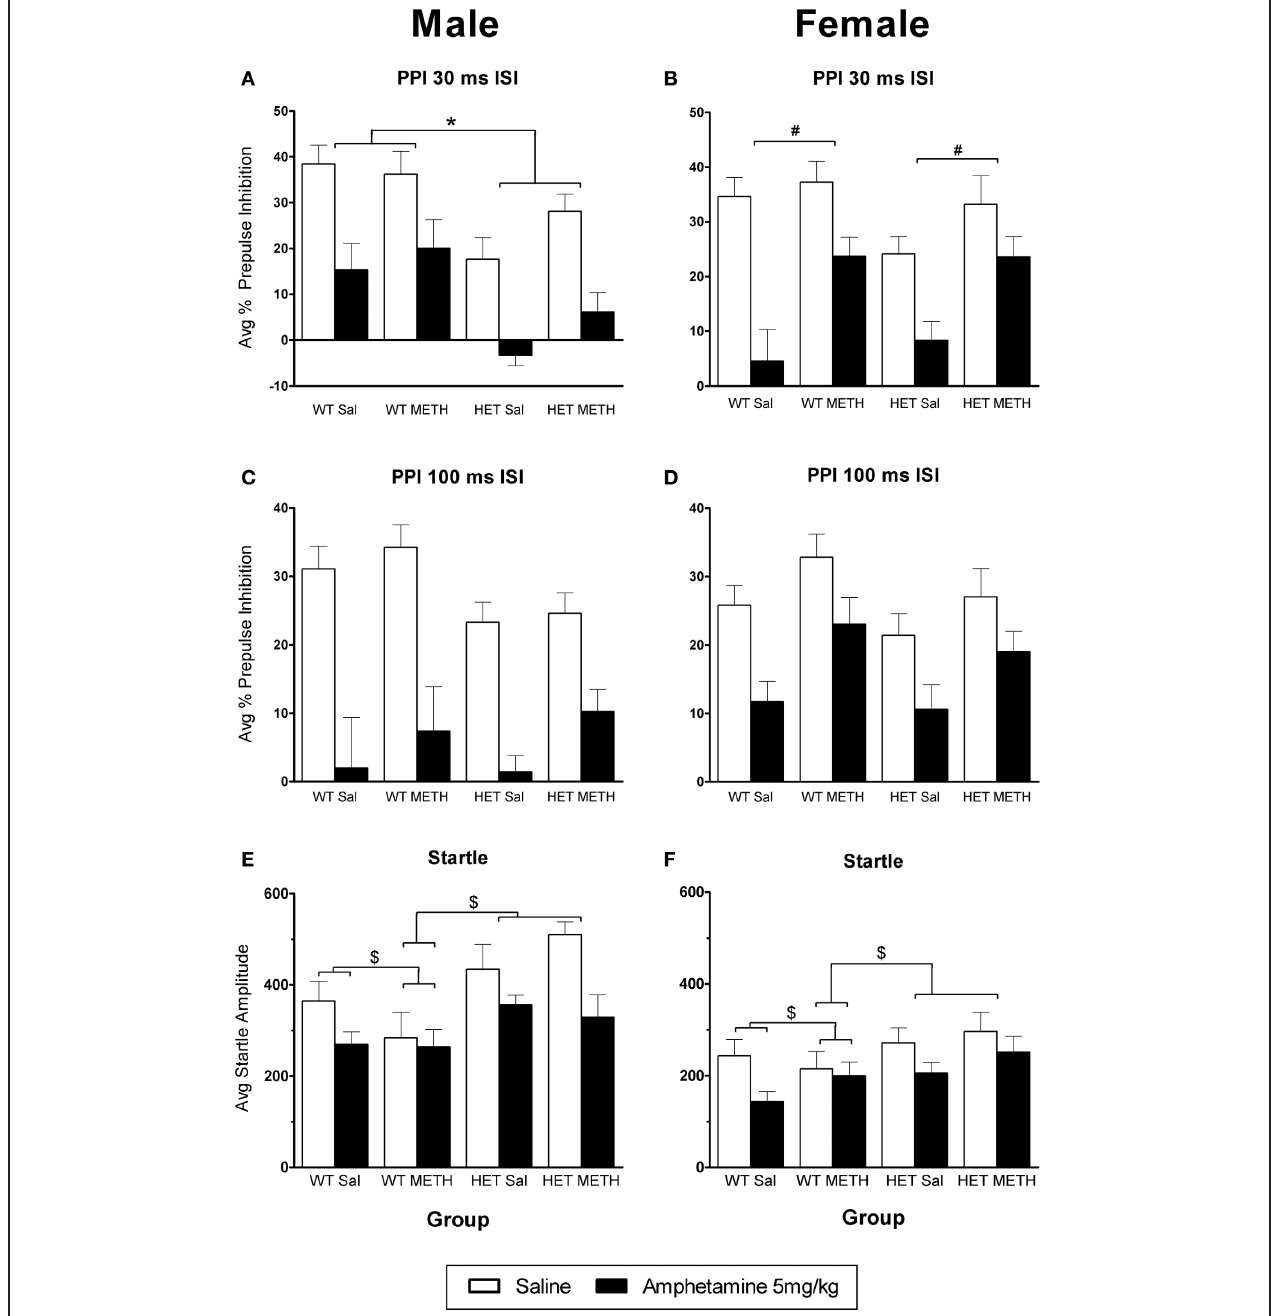
FIGURE 3 | AMPH-induced disruption of PPI. (A,B) At the 30ms ISI, following an AMPH challenge, PPI was disrupted in all groups, however the effect of AMPH was enhanced in male BDNF HETs (A) , and was attenuated in female mice treated with METH (B) . (C,D) At the 100ms ISI, following an AMPH challenge PPI was disrupted in all groups, however this was not